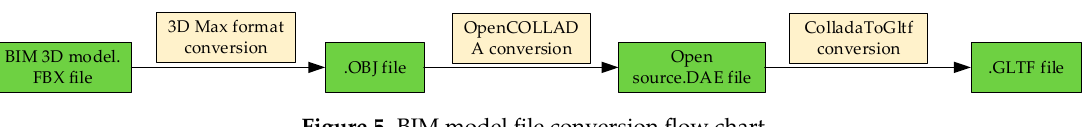
Figure 5. BIM model file conversion flow chart.